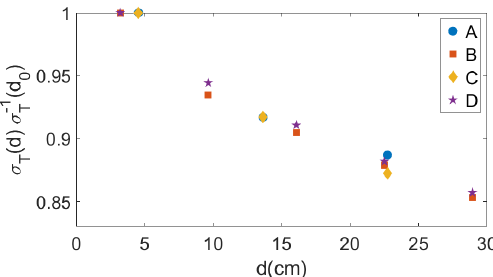
Figure 4. The normalized standard deviation of T as a function of the sensor pathlength. Path averaging over ≈ 12.5cm results in a measured σ(d) that is ≈ 92% of σ(d 0 ) . See Fig. 3 for lines A, B, C, and D.